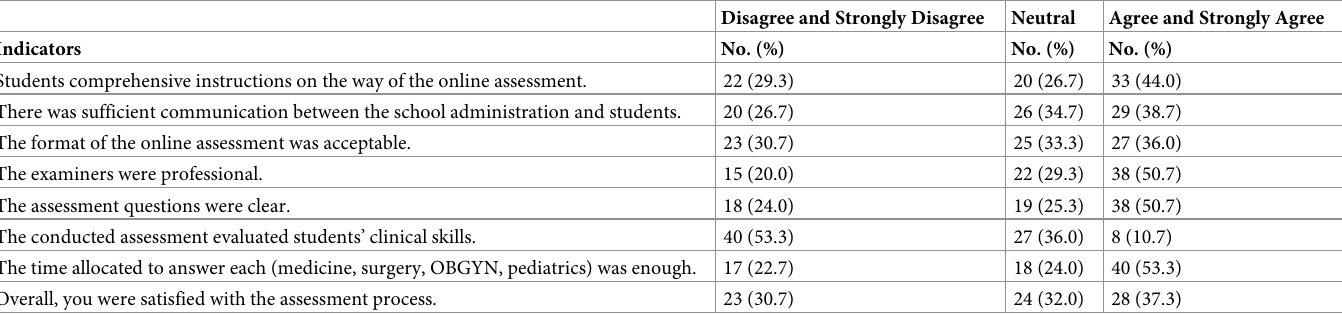
Table 2. Students’ perception about the assessment